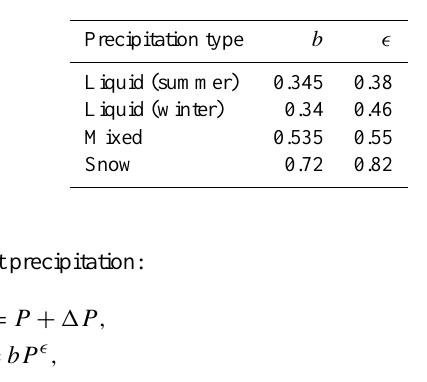
Table 1. Site-specific wind exposition coefficient b (-) and empiric precipitation type coefficient (cid:15) (-) for different precipitation types at an open-space gauge location.